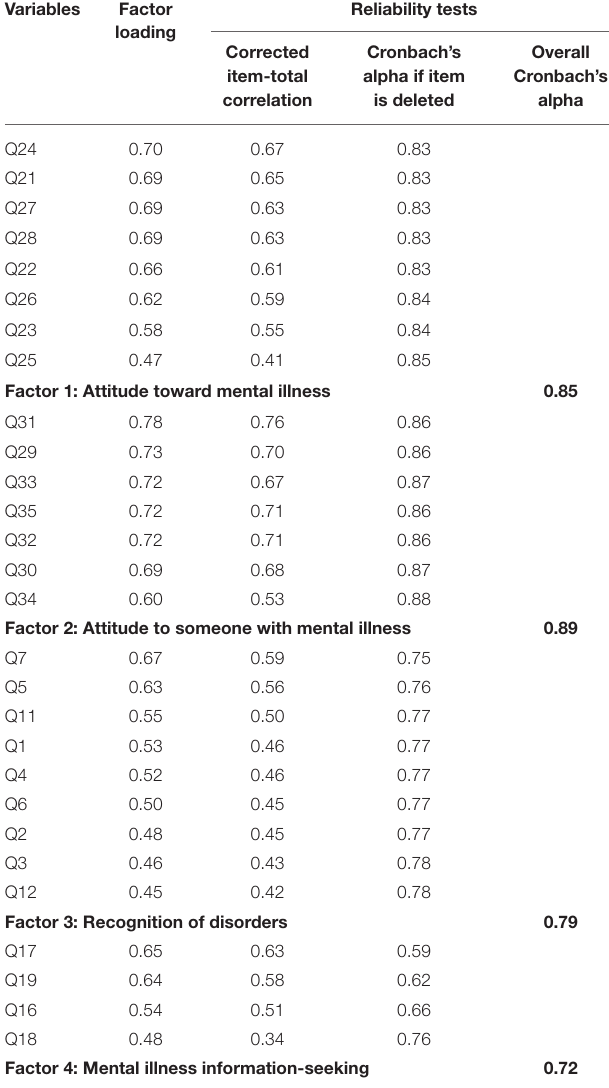
TABLE 1 | Results of exploratory factor analysis and reliability tests of Mental Health Literacy Scale (MHLS)—Arabic version ( N =